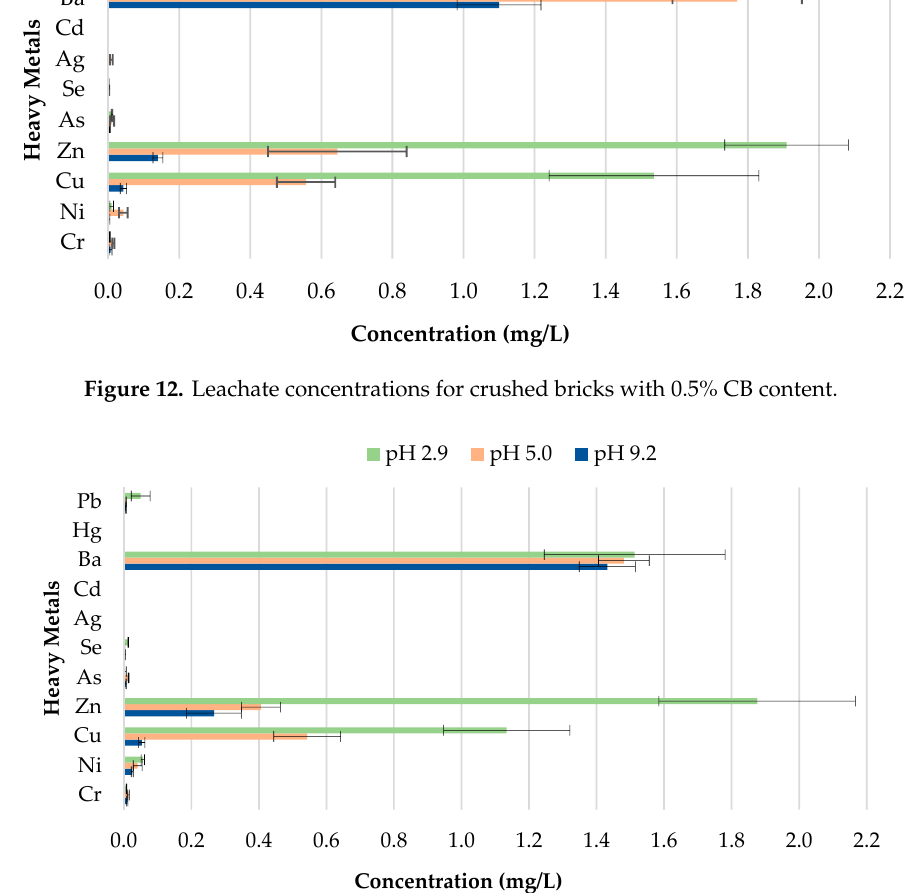
Figure 13. Leachate concentrations for crushed bricks with 1% CB content.